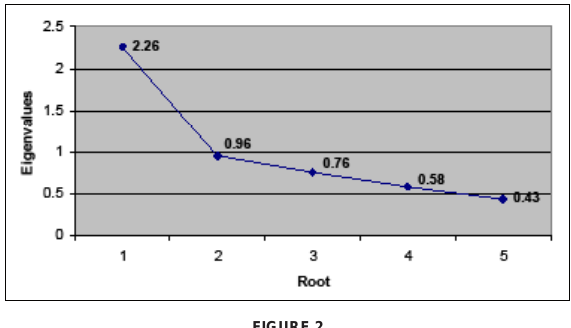
FiGure 2 total group